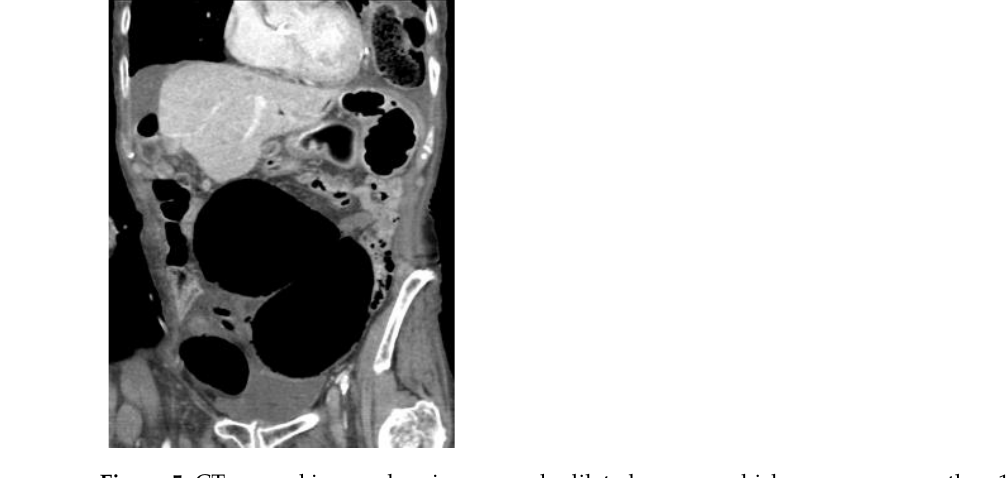
7 Figure 3. CT topogram demonstrating classical features of a caecal volvulus. The sensitivity and specificity are increased with a barium enema study up to 88%, with possible demonstration of the tapering end of the volvulus site, known as the bird- beak sign [17,19]. However, it is considered tedious and risky if patients are critically ill or if there is a suspicion of gangrene or perforation [22]. 4.4.2. Computerised Tomography (CT) Scan In five of our patients, the emergency physician considered a CT even before any classical radiographic examinations. It is justified because of the high sensitivity and spec- ificity of CT which are 100% and 76.2%, respectively [23]. Our study finding of diagnostic features (Figures 4 – 10) concurs with signs including one or two transition points, X- marks-the-spot sign, whirl sign, split-wall sign, hugely dilated caecum, dilated proximal small bowel and decompressed distal large bowel, which are all described as CT findings with variable sensitivity, specificity, and predictive values with some of them approach- ing near 100% [24].